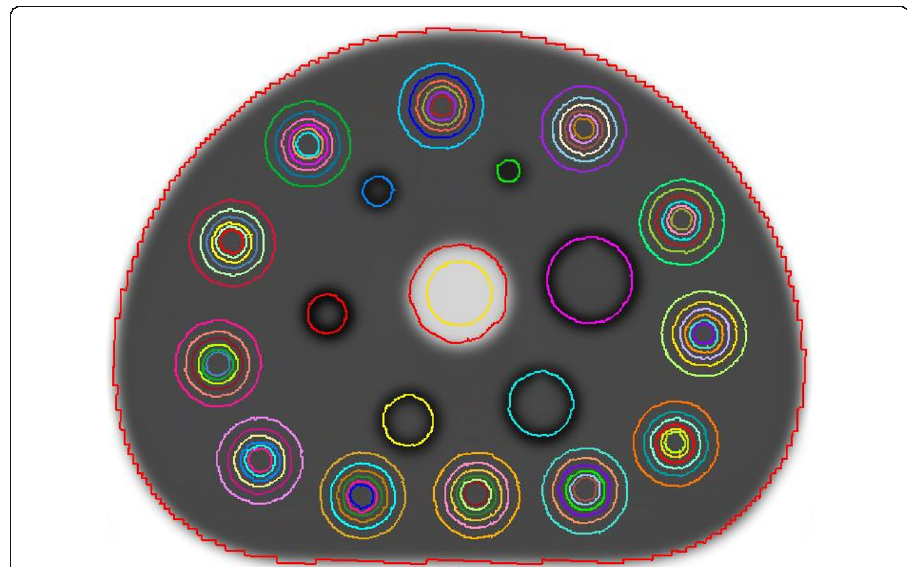
Fig. 1 Attenuation map of NEMA 2007/IEC 2008 body phantom with VOIs drawn around each of the six fillable spheres, 72 VOIs drawn in the background compartment, and a 28-mm diameter VOI drawn in the cold insert (center, yellow)